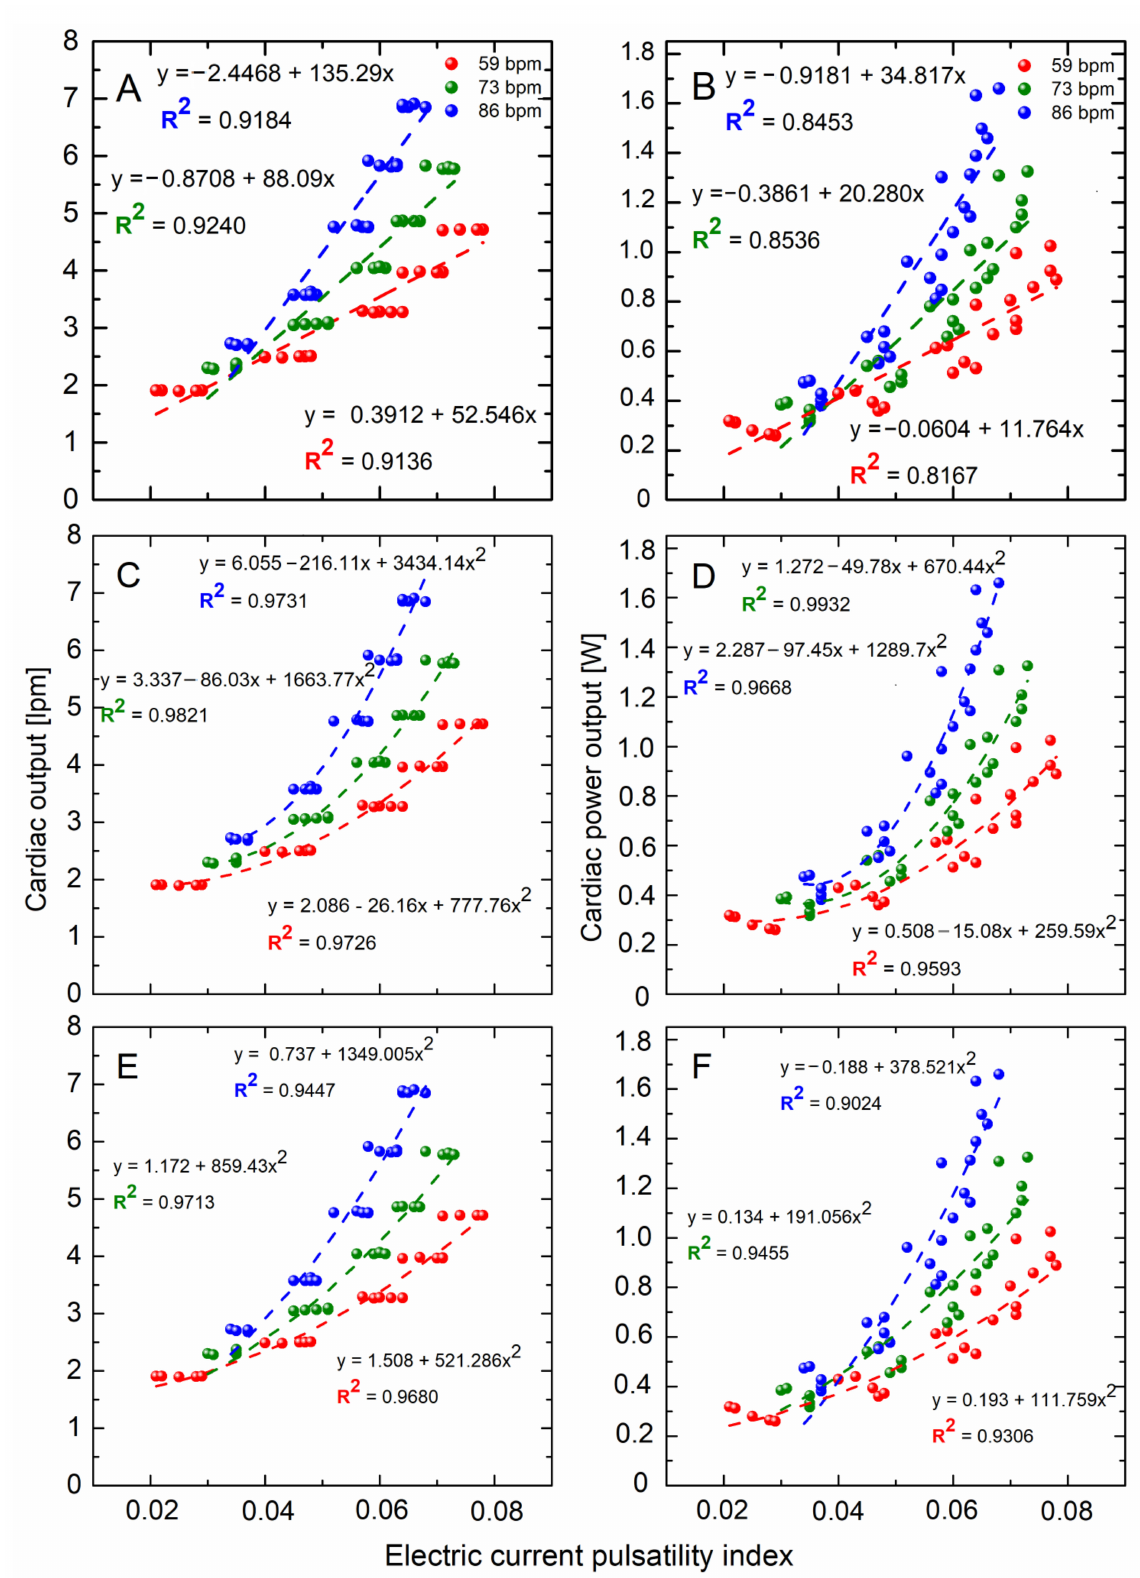
Figure 4. Measured data sets and regression models of cardiac output ( A , C , E ) and cardiac power output ( B , D , F ) versus pulsatility index of the Sputnik LVAD electric current for three heart rate values—59 (red), 73 (green) and 86 (blue) bpm. Regression equations and coefficients of determination adjusted to the number of coefficients are given near the curves. Error bars correspond to the point